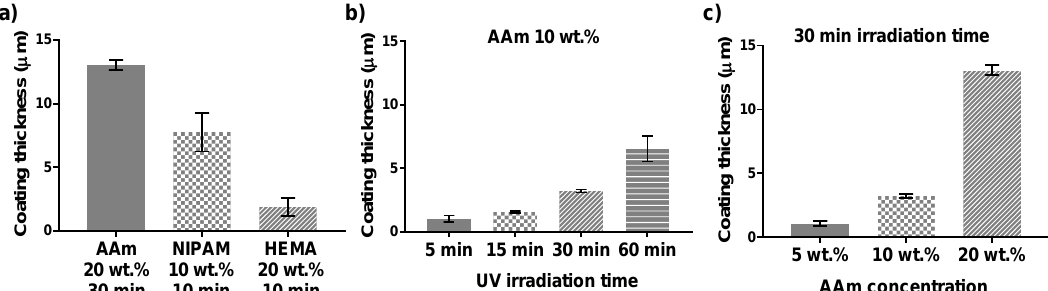
Figure 7. Coating thicknesses of coated PDMS surfaces according to Si content profile by SEM ‐ EDS: ( a ) PDMS surface coated with acrylamide 20 wt %, NIPAM 10 wt %, and HEMA 20 wt %, irradiated for 30, 10, and 10 min, respectively; ( b ) PDMS surface coated with acrylamide 10 wt % and irradiated with different UV irradiation times; ( c ) PDMS surface coated with different concentrations of acrylamide and UV irradiated for 30 min.